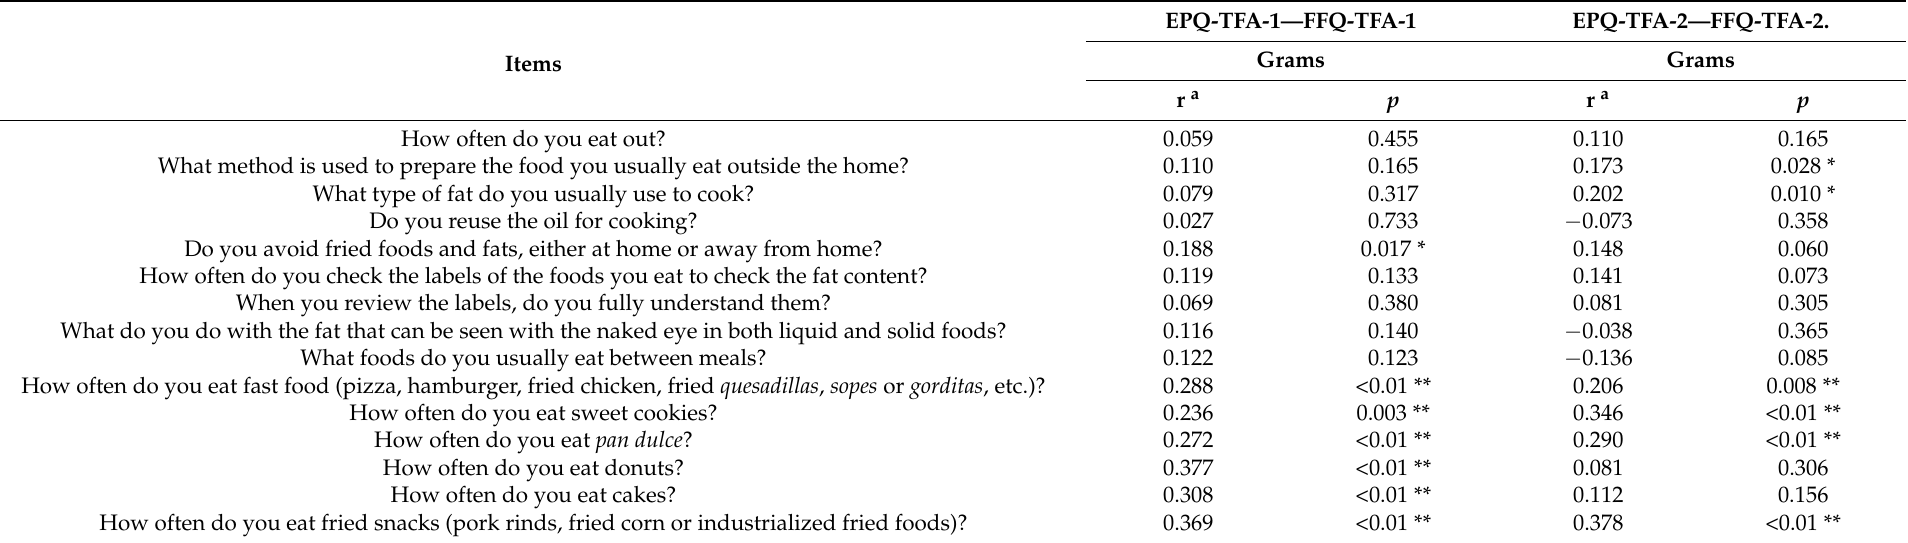
Table 6. Relationship of items of the EPQ-TFA-1 and EPQ-TFA-2 with the estimation of TFA consumption from the FFQ-TFA-1 and the